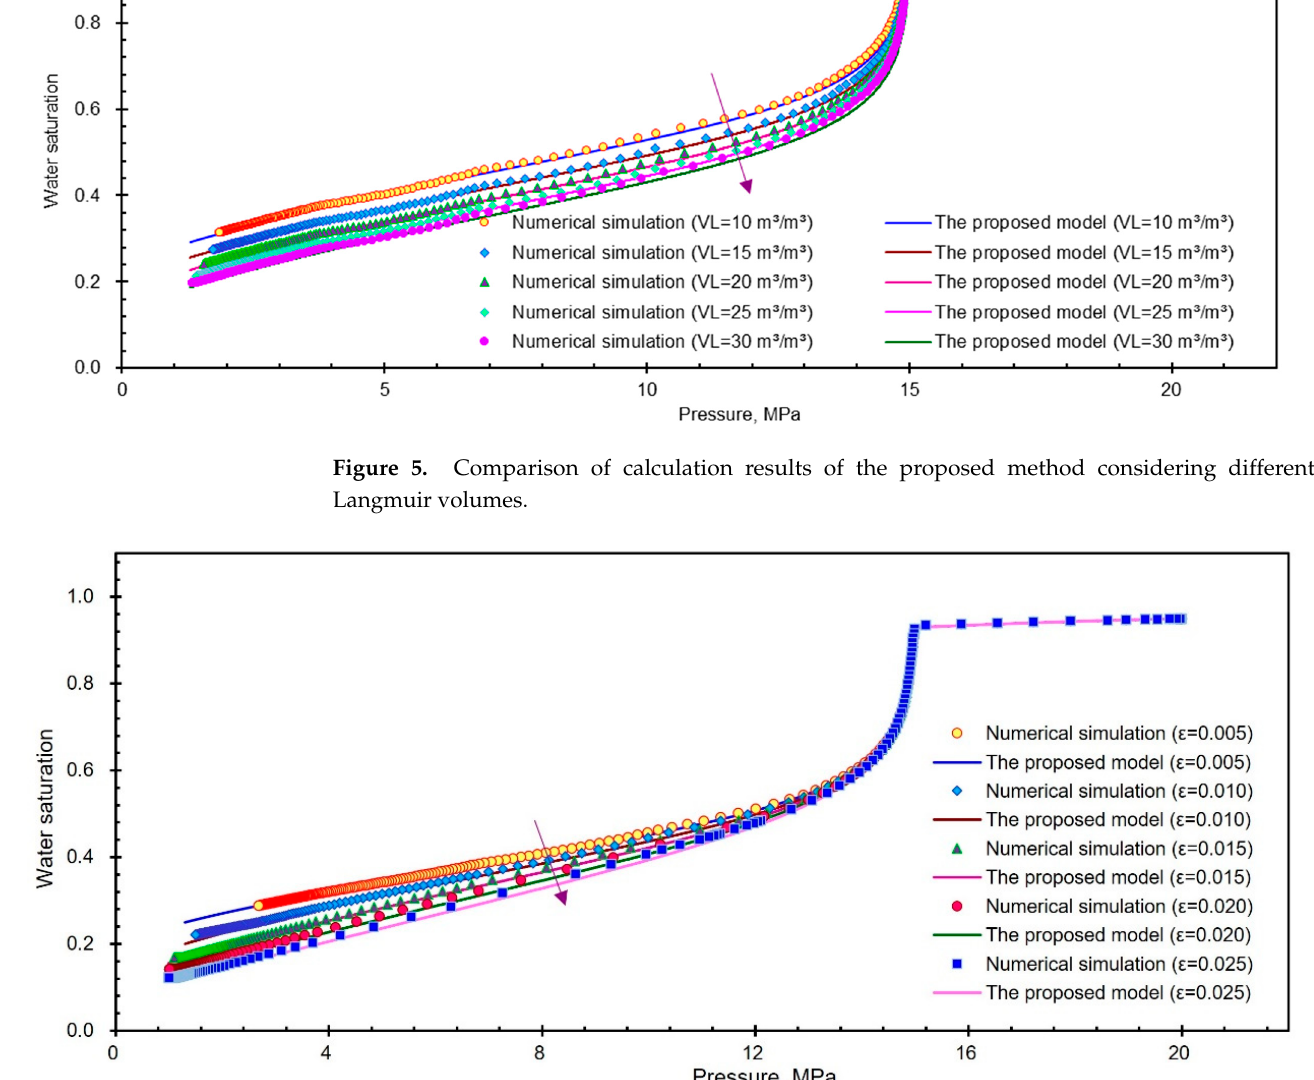
Figure 5. Comparison of calculation results of the proposed method considering different Langmuir volumes.